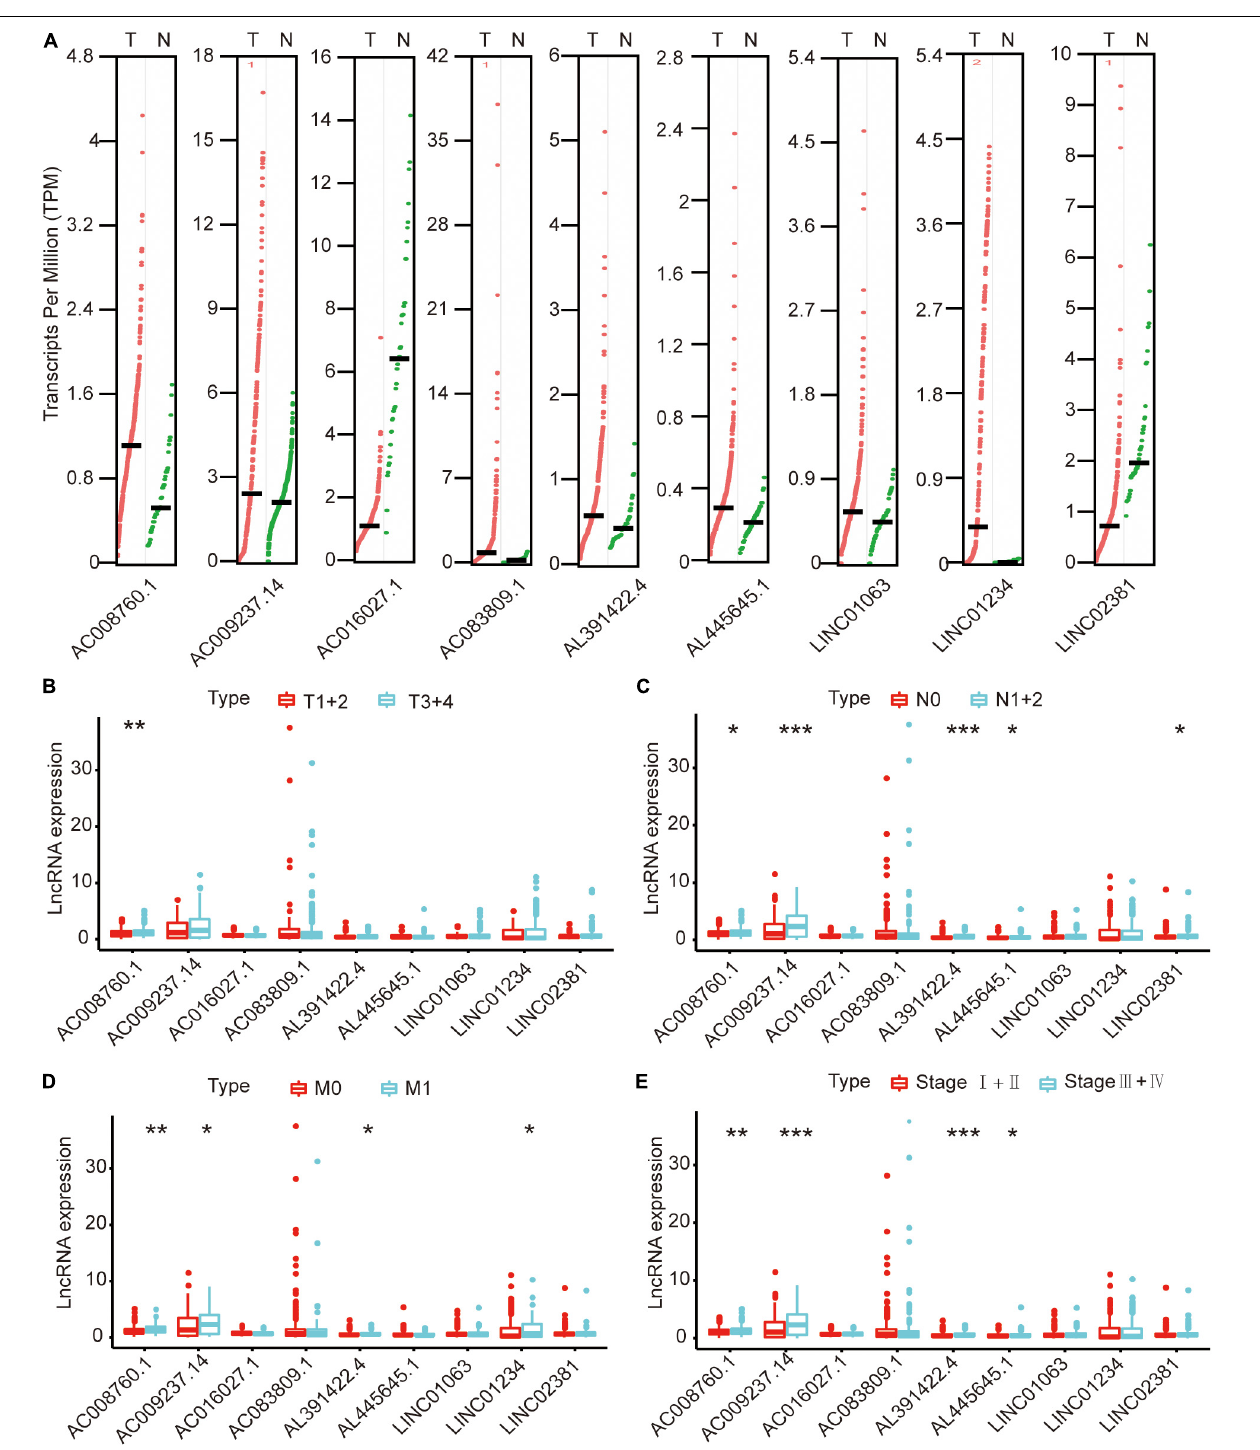
FIGURE 7 | Relationship between nine lncRNAs and clinical characteristics of colon cancer in the entire TCGA cohort. (A) Expression levels of nine lncRNAs in the GEPIA database. (B) Relationship between the expression of nine lncRNAs and the depth of colon cancer tumors. (C) Relationship between the expression of nine lncRNAs and the number of lymphoma in colon cancer. (D) Relationship between the expression of nine lncRNAs and metastasis of colon cancer cells. (E) Relationship between the expression of nine lncRNAs and clinical stage of colon cancer. * p < 0.05, ** p < 0.01, *** p < 0.001.